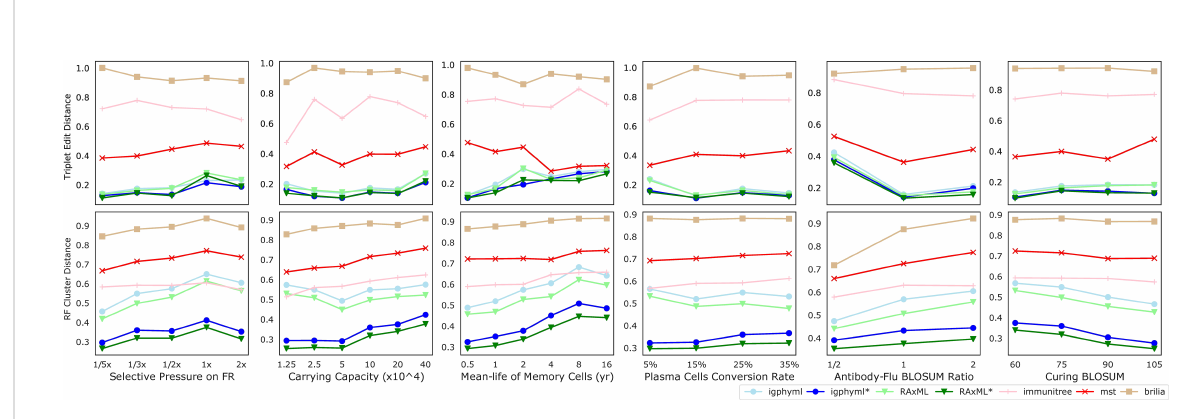
FIGURE 9 Triplet edit distances and RF cluster distances by selective pressure on framework region, carrying capacity, mean-life of memory cells, plasma cell conversion rate, antibody- fl u BLOSUM ratio (MARatio), stage change threshold (M).